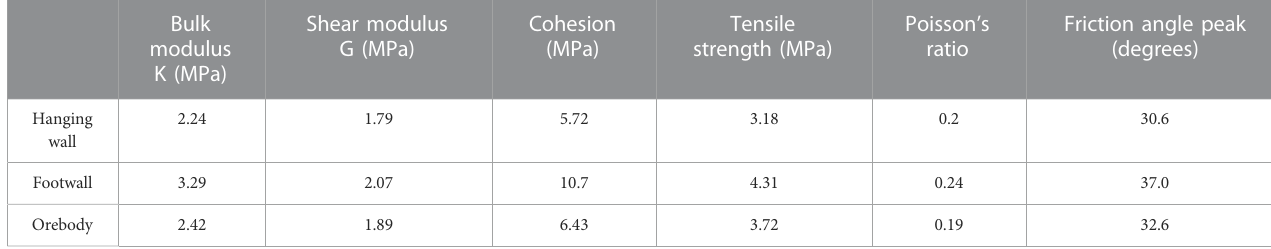
TABLE 1 Main parameters of the hanging wall, footwall, and